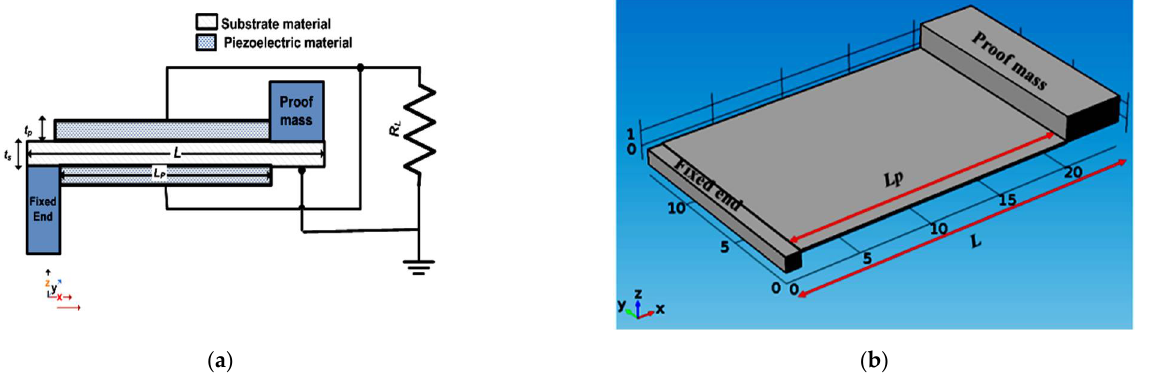
Figure 1. ( a ) Demonstration for the modified traditional structure and ( b ) 3D view of the modified traditional structure. Table 1. Main design parameters of the modified traditional structure case study.